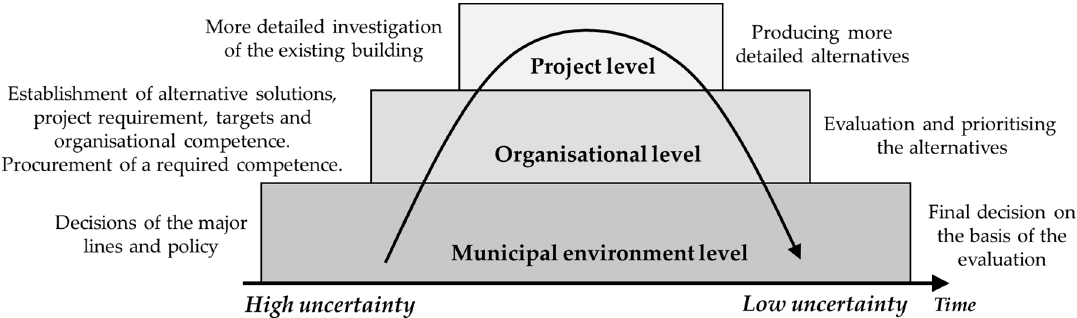
Figure 4. The proposal of a process for decreasing the uncertainty in an early phase of a municipal building refurbishment project.